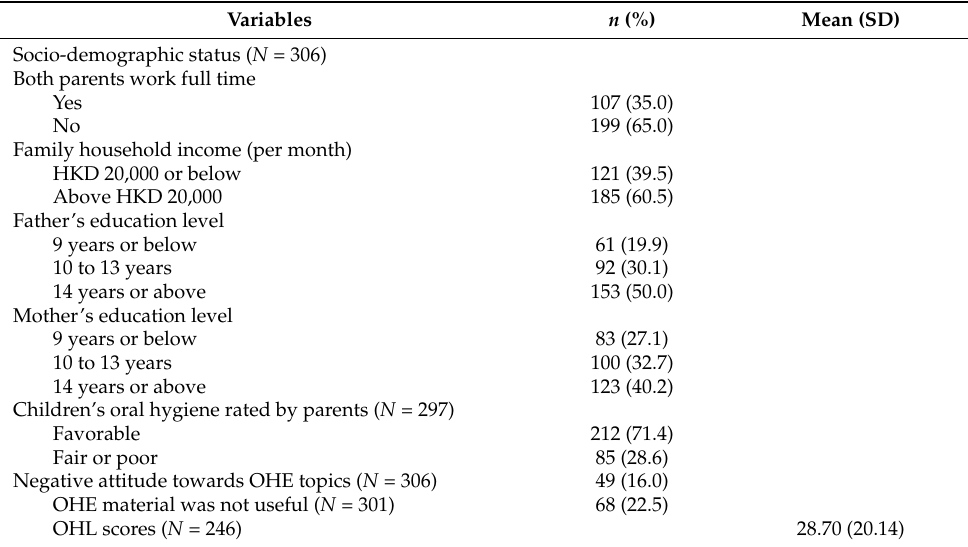
Table 1. Participant